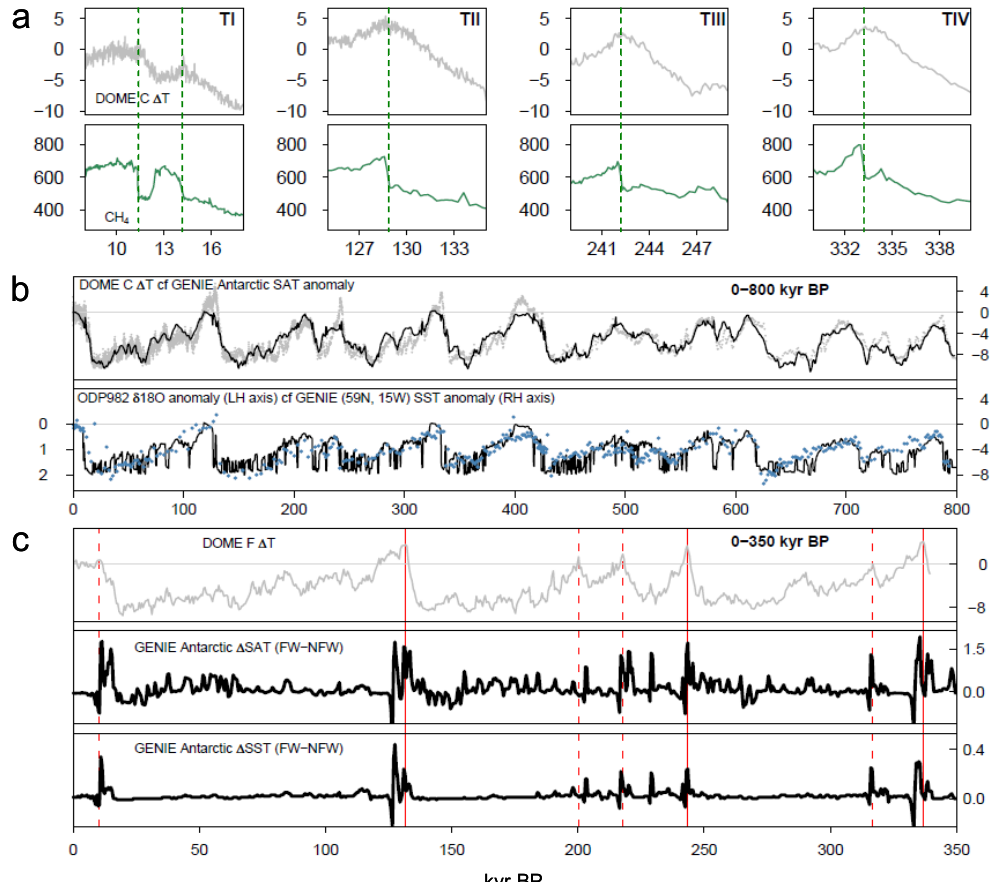
Fig. 1. (a) DOME C δ D-inferred Antarctic temperature anomaly (Jouzel et al., 2007) (grey) and atmospheric CH 4 concentration (Loulergue et al., 2008) (green) at the last four terminations. (b) 800kyr records of DOME C Antarctic temperature anomaly (grey) and planktonic δ 18 O anomaly (blue) at ODP site 982 (57.3 ◦ N, 15.5 ◦ W) (Venz et al., 1999), compared respectively with the GENIE-1 (G FW ) Antarctic SAT anomaly and the SST anomaly at the grid cell centred on 59 ◦ N, 15 ◦ W. (c) 350kyr records of DOME F δ D-inferred Antarctic temperature anomaly (Kawamura et al., 2007) (grey), GENIE-1 meltwater-induced (G FW -G NFW ) Antarctic SAT and SST anomalies. SAT is averaged over Antarctica south of 71 ◦ S. SST is averaged over all the Southern Ocean south of 62 ◦ S. Note: the simulation in (b) includes meltwater forcing, but the effects in Antarctica (up to ∼ 1.5 ◦ C warming) are largely obscured by the larger changes across the